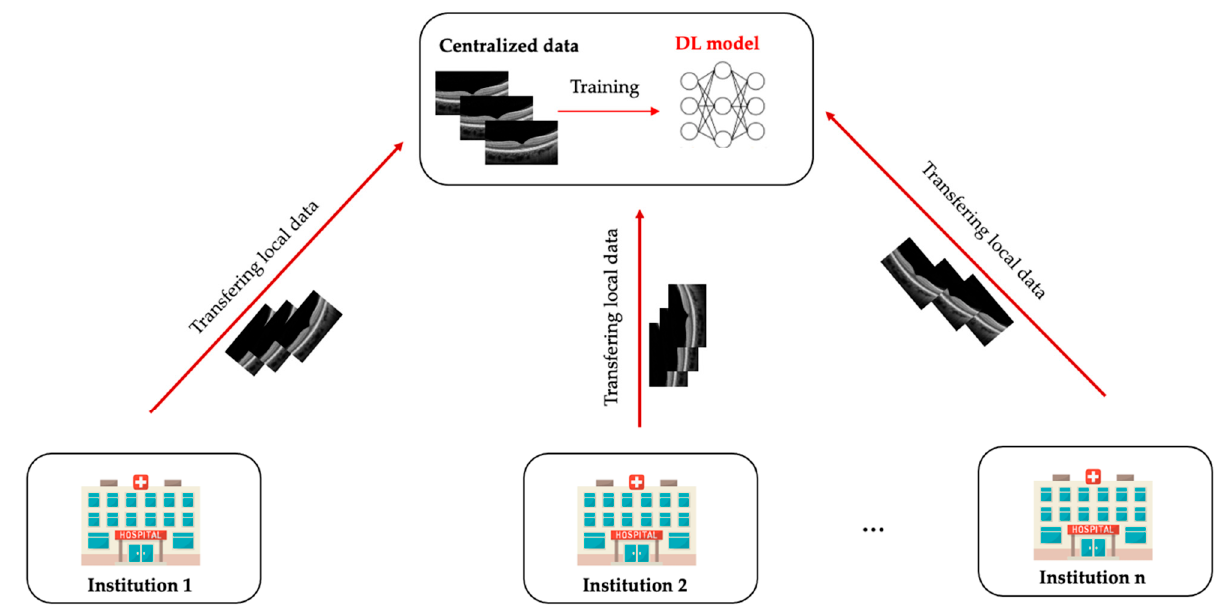
Figure 1. Conventional centralised learning. All participating institutions transfer their dataset to a centralised location, where the deep learning model is developed.